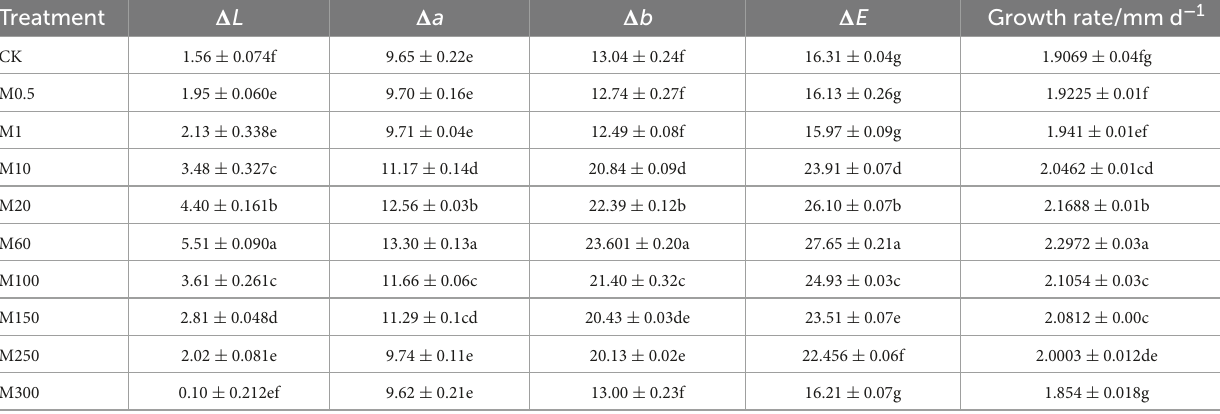
TABLE 2 Comparison of color changes of W5-3 colonies treated with different concentrations of MT.